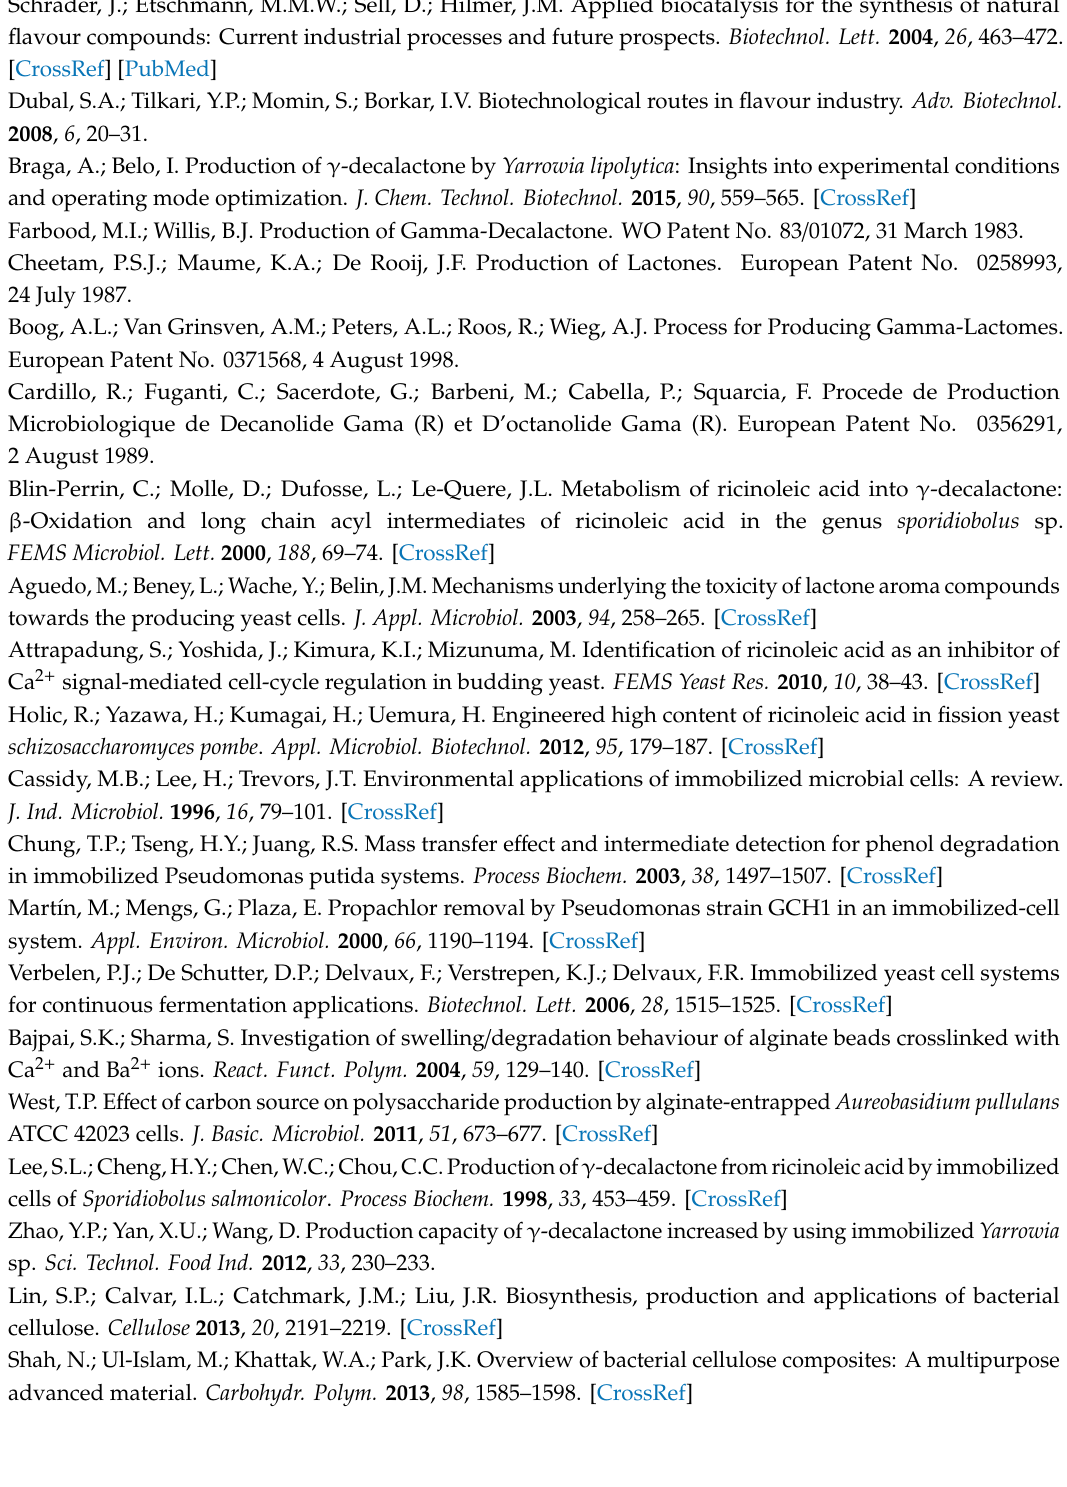
gamma-decalactone (GDL), ricinoleic acid (RA), bacterial cellulose (BC), alginate (ALG), bacterial cellulose–alginate (BC–ALG), free suspended culture (FSC), Yarrowia lipolytica ( Y. lipolytica ), Scanning electron microscopy (SEM), high-performance liquid chromatography (HPLC), Fourier transform infrared spectroscopy